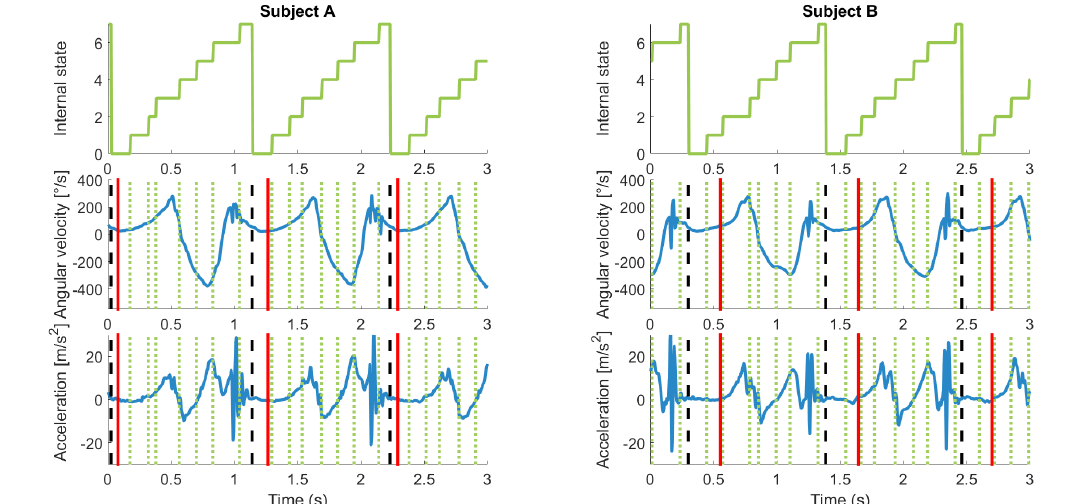
Figure 6. Example of estimated and ground truth labels for two subjects. Left column, Subject A; right column, Subject B. Top row , internal states of hHMM with eight internal states. Middle row , gyroscope sagittal plane signal. Bottom row , vertical acceleration plane. The vertical dotted lines correspond to the internal states. The dashed vertical lines correspond to the estimated start of each cycle. The vertical solid lines refer to the reference labels. The reference labels are inconsistent: for Subject A, they appear at a local minimum and for Subject B not at the local minimum. Some internal states seem to correspond to meaningful data points such as minimums and